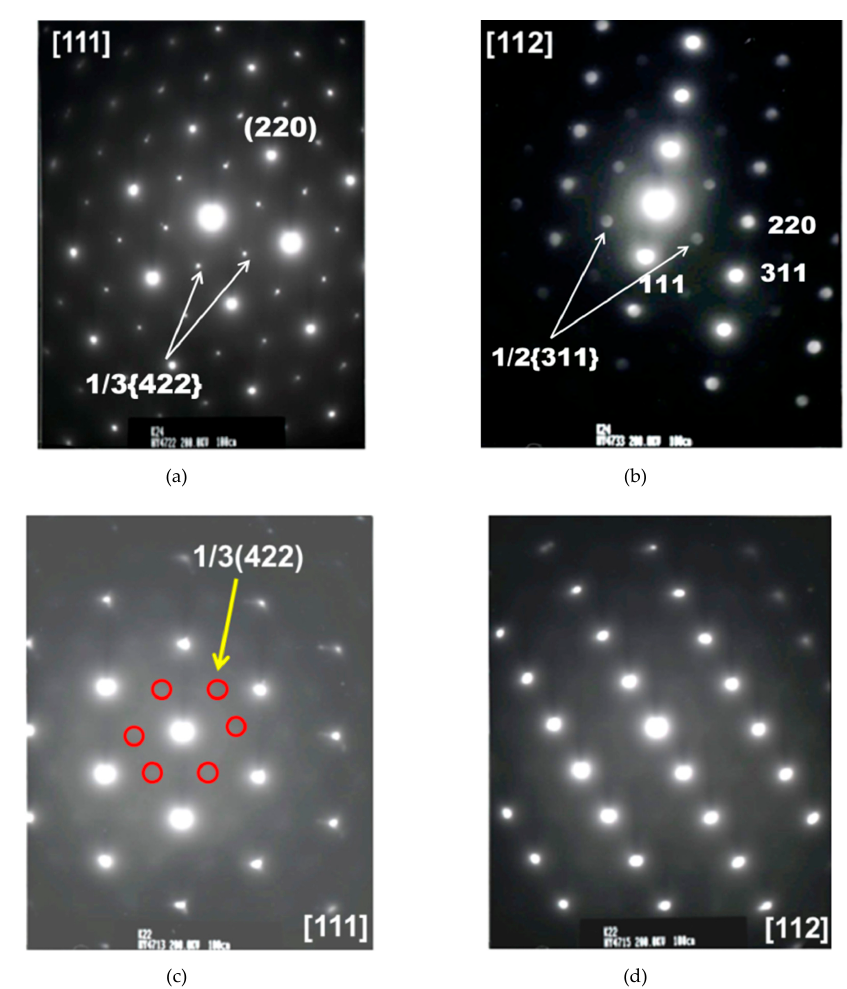
Figure 4. Diffraction patterns taken along the [111] and [112] zone axes of a 316 SS after tensile tests in ( a,b ) hydrogen and ( c,d ) air, respectively (adapted from [8] with permission from BH Choe, 2019).